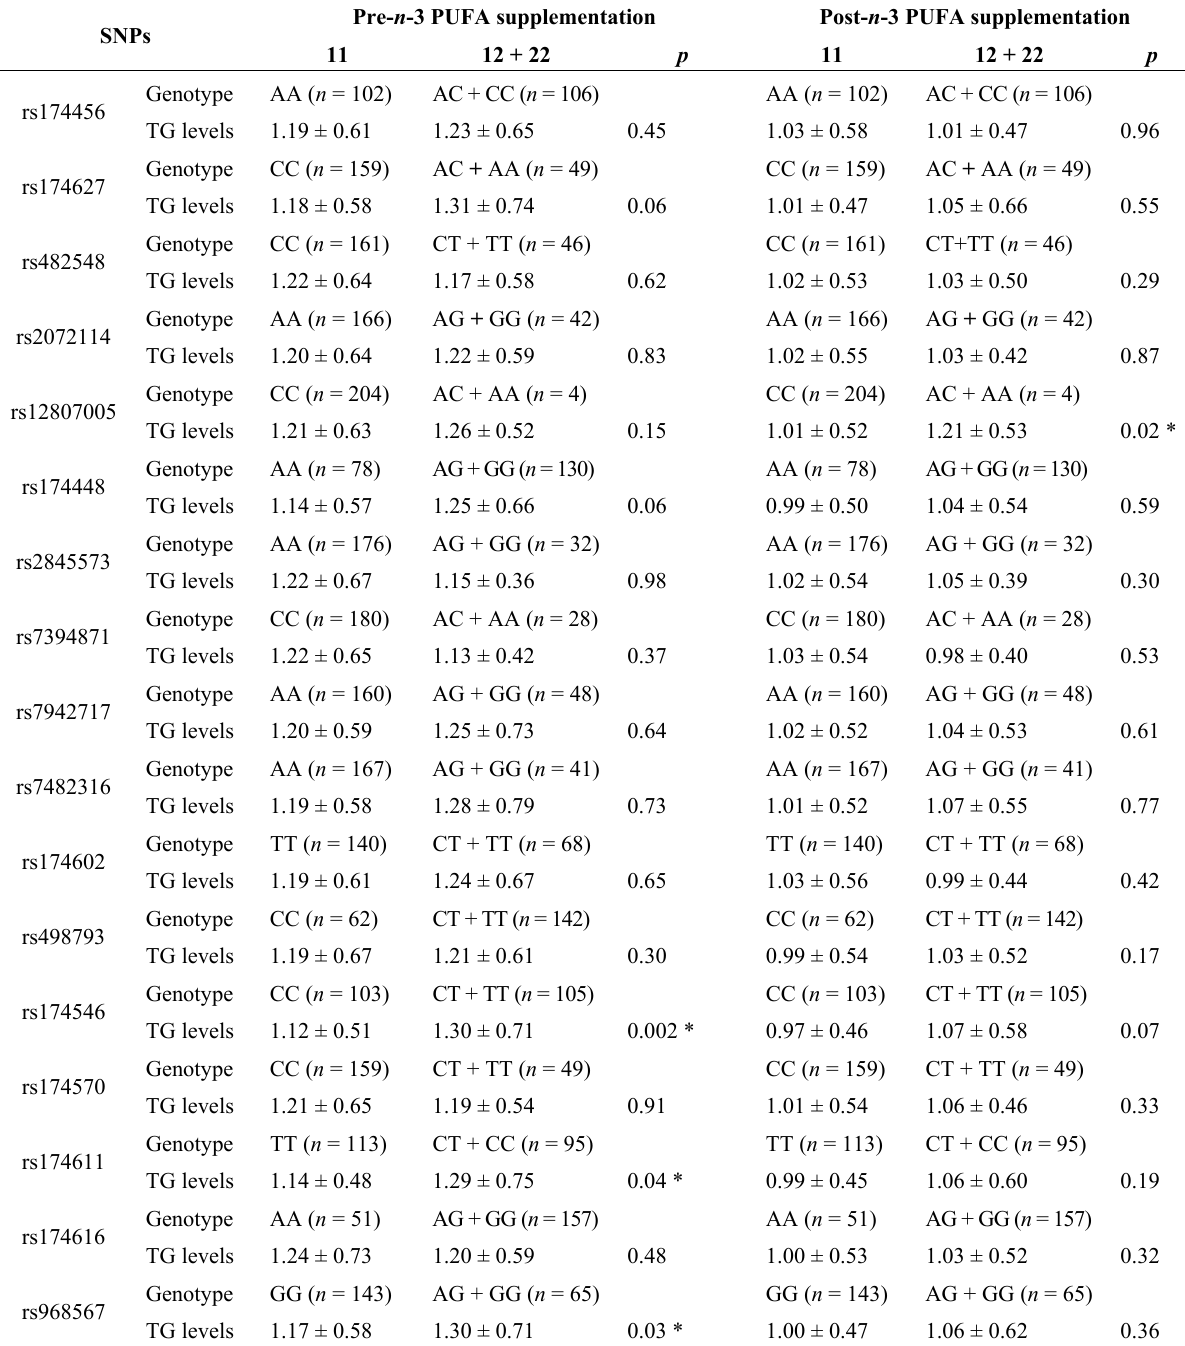
Table 5. Triacylglycerol (TG) concentrations according to genotype distributions of the FADS gene cluster polymorphisms before and after a 6-week n -3 PUFA